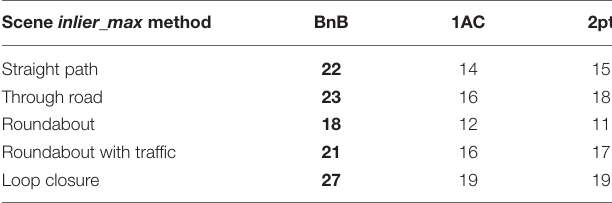
TABLE 2 | Five pairs of consecutive frames selected from the Malaga dataset